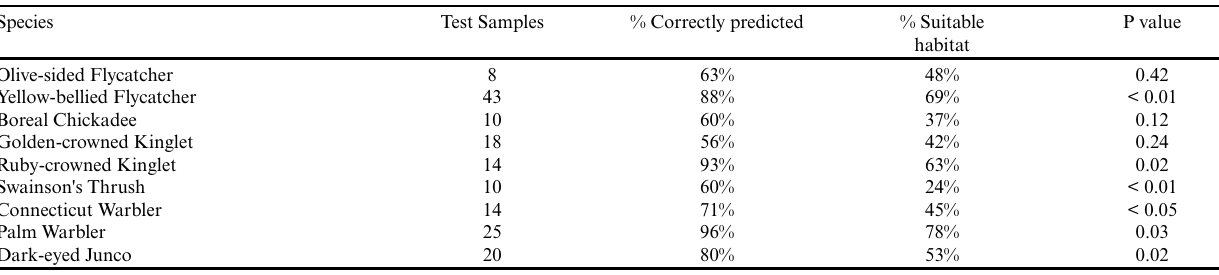
Table 5 . Test results of predictive ability of MaxEnt models for bird species in the Agassiz Lowlands of Minnesota. Suitability predictions from top models for each species were transformed into binary maps using the top 90% of model training data and then tested against independently collected datasets. The proportion of test data correctly predicted by each species’ top model is reported. In addition, the proportion of suitable lowland conifer habitat (out of all available state-owned lowland conifer) is included. Significance values are results of chi-square tests taking into account the observed and expected number of correct predictions based on the proportion of the study area predicted to be suitable. See Table 2 for species scientific names.